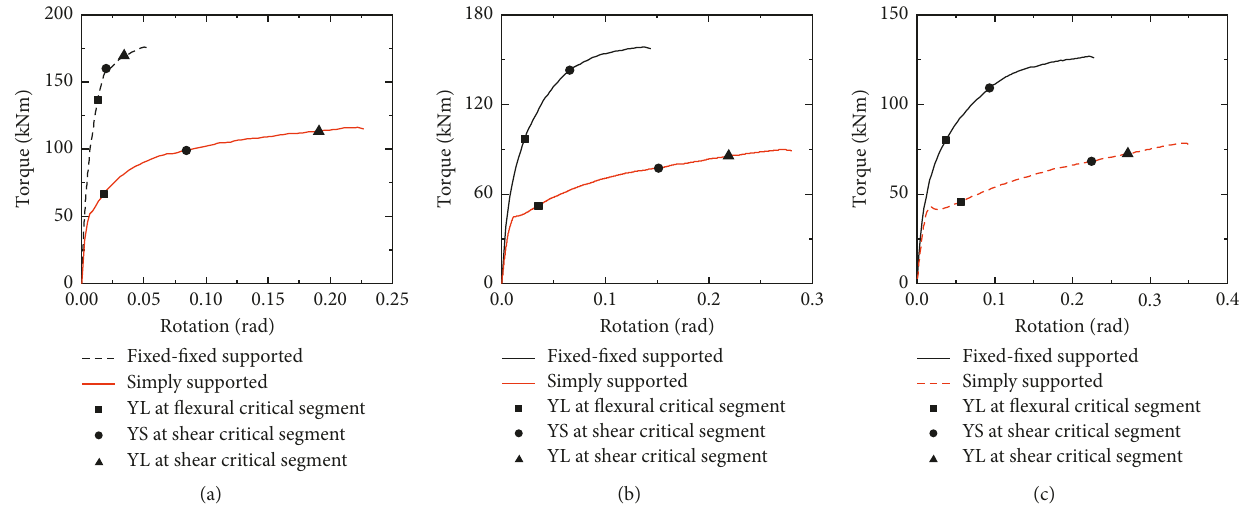
Figure 17: Simulated torque-rotation curves under different boundary conditions with (a) SL-CL ratio of 2.0, (b) SL-CL ratio of 3.0, and (c) SL-CL ratio of 4.0. “SL-CL ratio” means span length-characteristic length ratio; “YL” means yielding of longitudinal bars; “YS” means yielding of